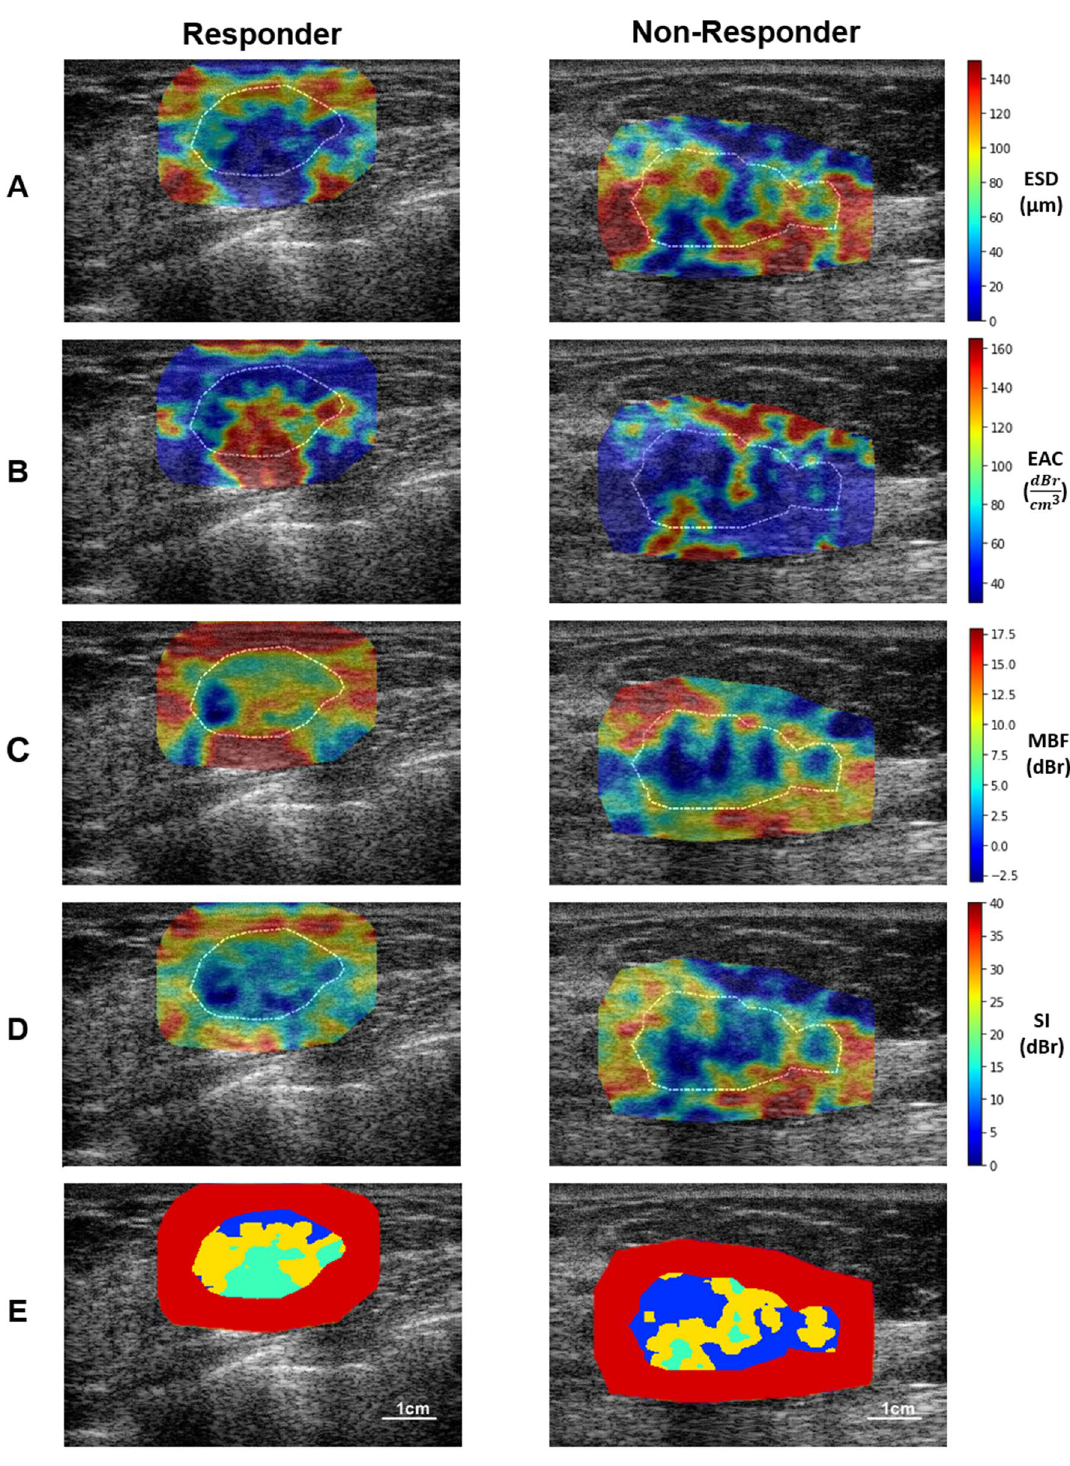
Figure 2. A - D : Ultrasound B-mode images with parametric overlays of ESD ( A ), EAC ( B ), MBF ( C ), and SI ( D ) acquired from a representative responder and non-responder to NAC. The tumor core has been outlined with white dashed line. ( E ) distinct intra-tumor regions (region 1: green, region 2: yellow, region 3: blue) segmented using the HMRF-EM algorithm, surrounded by the tumor margin area